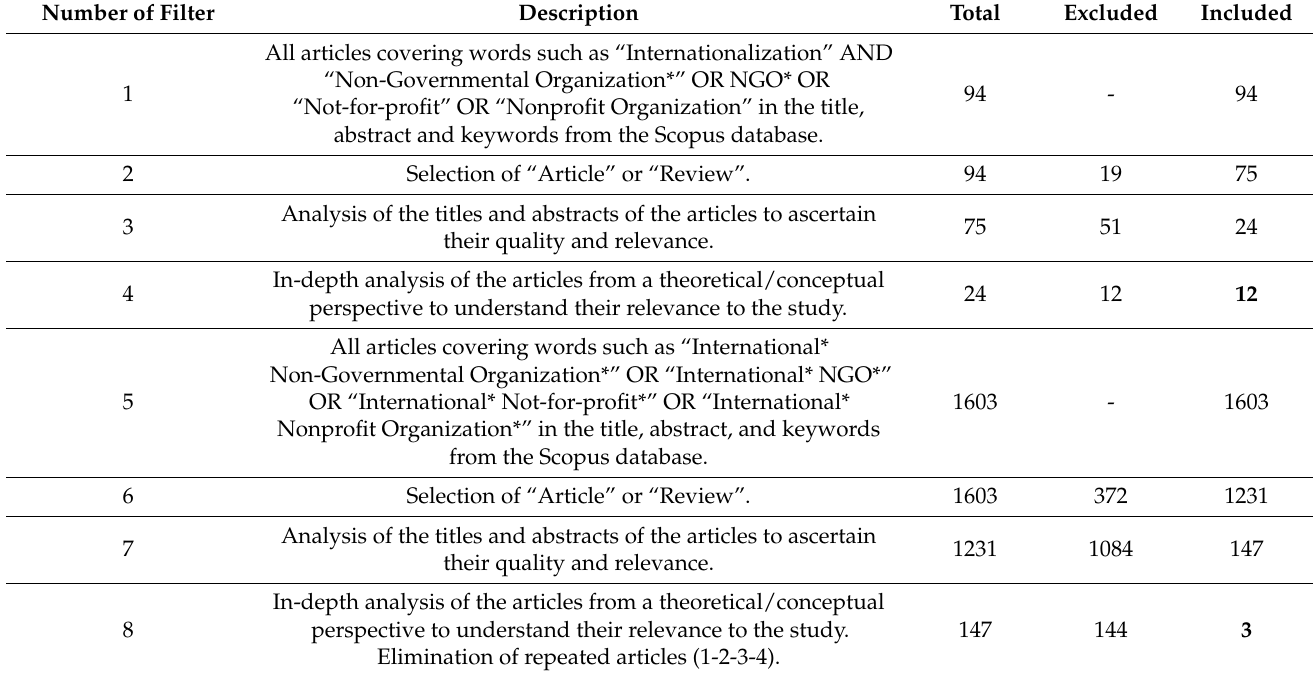
Table 1. Results of the search process with the Scopus